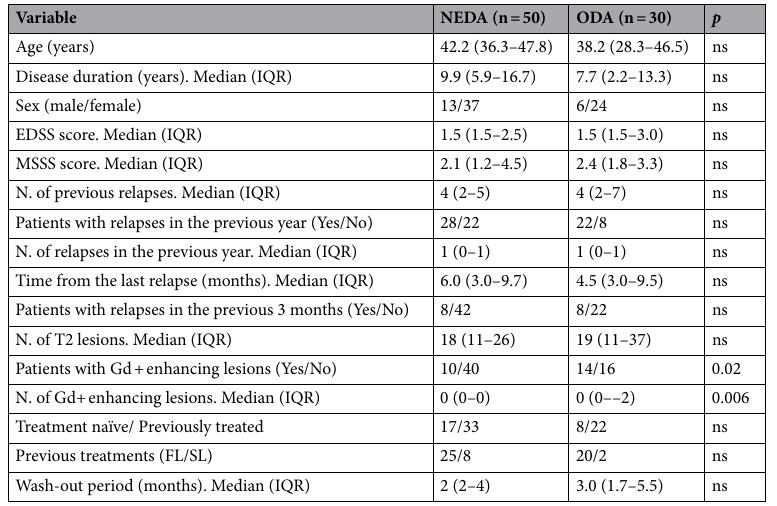
Table 2. Baseline clinical and demographic data of NEDA and ODA patients. EDSS Expanded Disability Status Scale, Gd Gadolinium, FL first line drugs, IQR interquartile range, NEDA no evidence of disease activity, MSSS Multiple Sclerosis Severity Score, N. number, NS NOT significant, ODA ongoing disease activity, SL second line